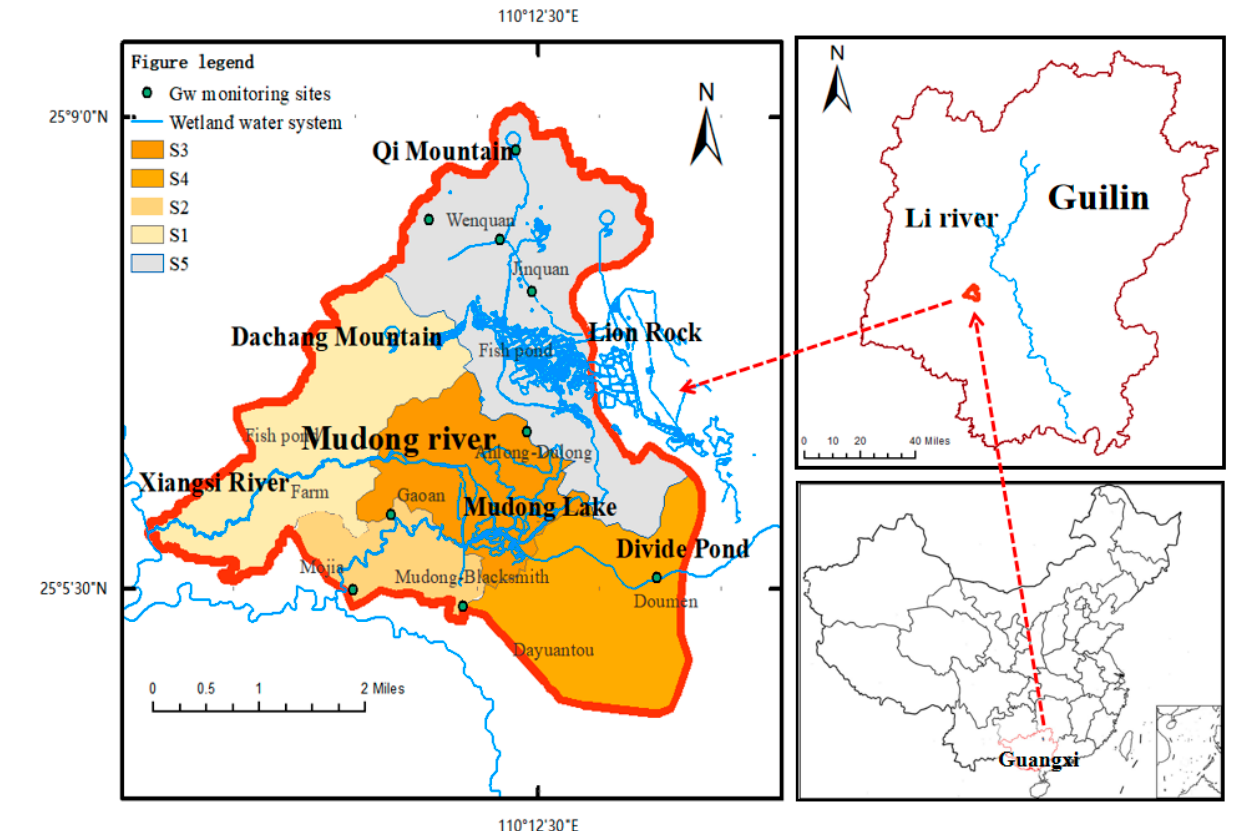
Figure 1. Distribution of sub-basins in the study area.